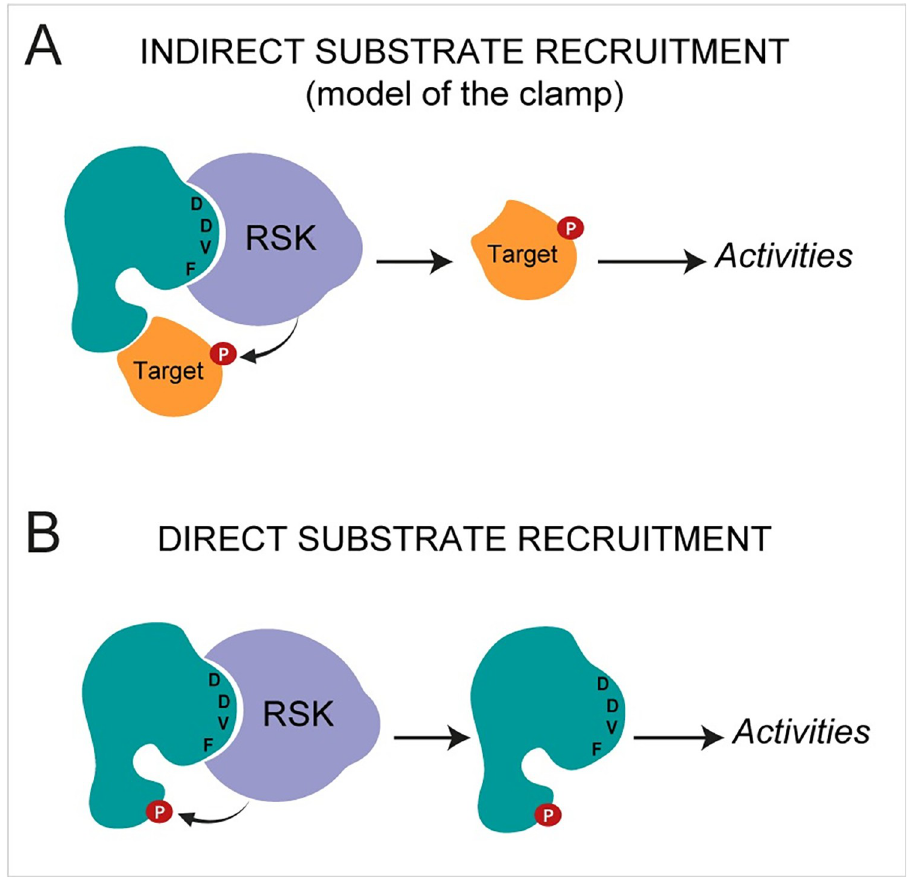
Fig 1. Pathogen’s proteins hijack RSK kinases. (A) Indirect substrate recruitment—model of the clamp: a pathogen’s protein acts as an adaptor protein, which binds and activates RSK through its DDVF motif and recruits a target protein to be phosphorylated by RSK through another domain. (B) Direct substrate recruitment. A protein interacts with RSK through its DDVF motif and is directly phosphorylated by RSK.